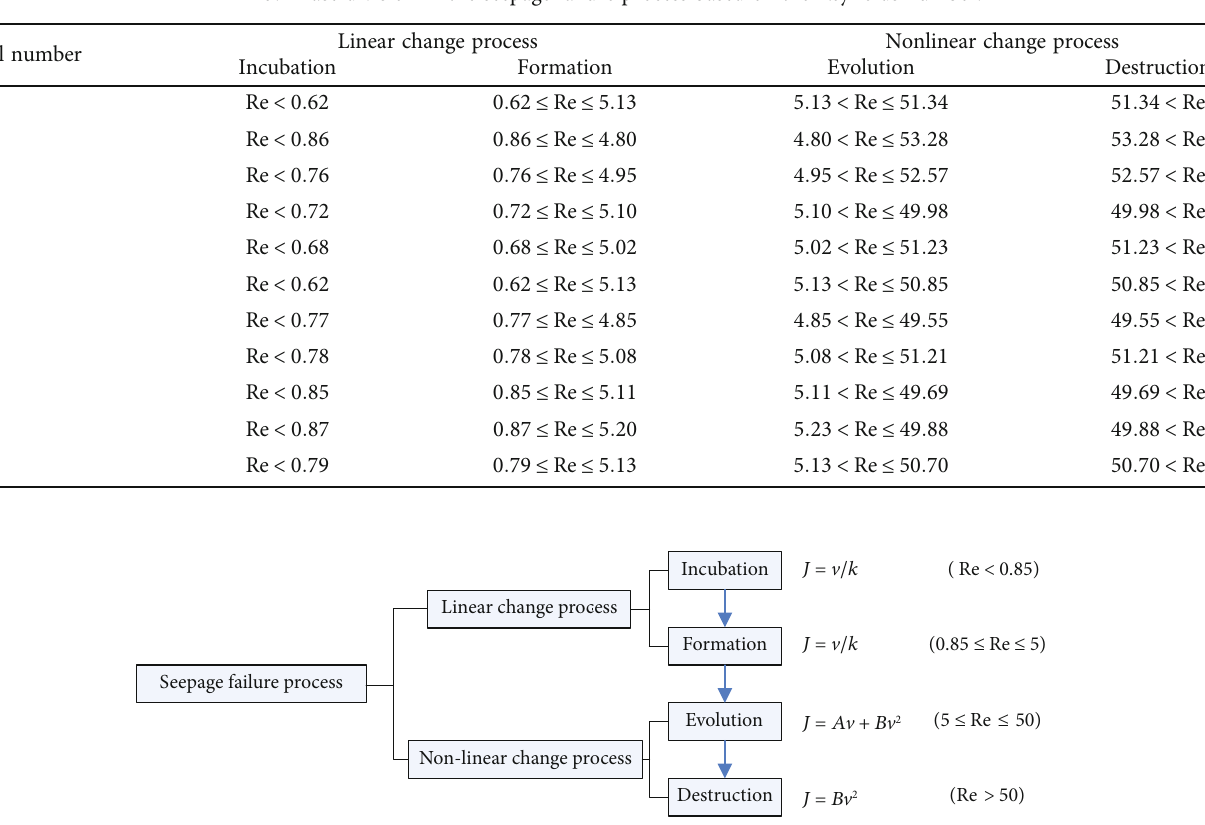
Table 3: Phase division in the seepage failure process based on the Reynolds number.